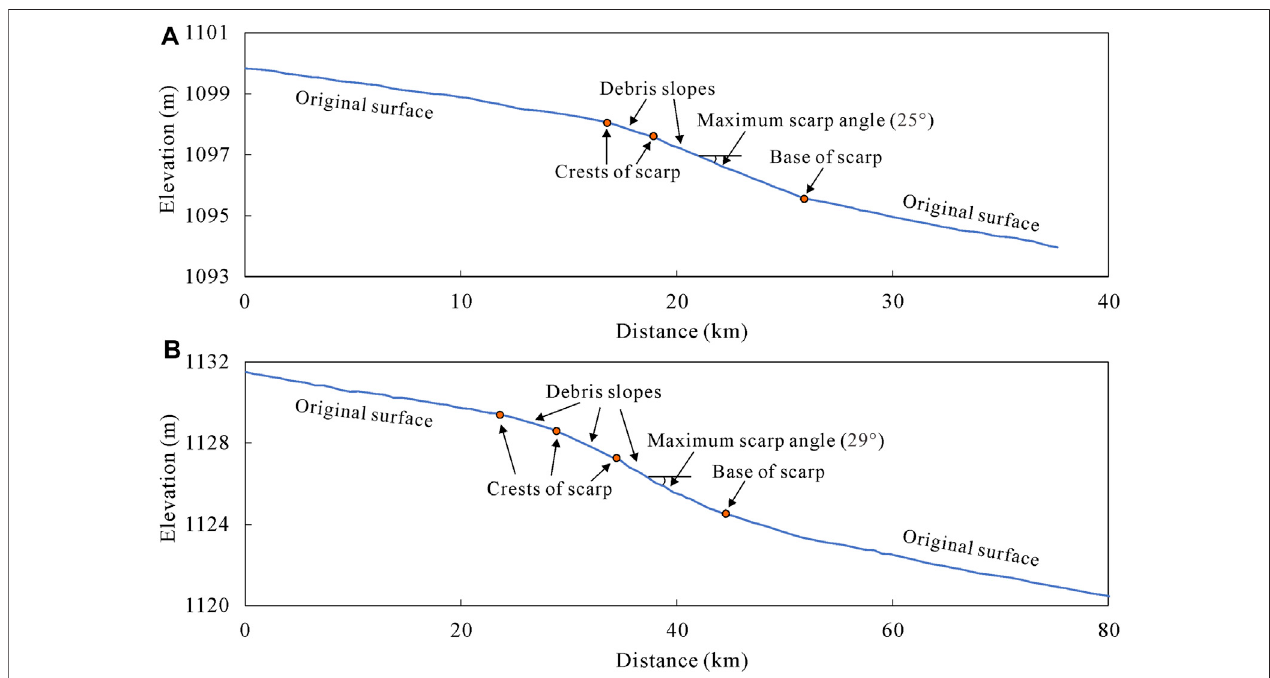
FIGURE5|(A) and (B) showtwoexamplesofcompositefaultscarppro fi lesattheWulashanPiedmontFaultwhicharecharacterizedbythecombinationofseveral different debris slopes in their morphology.